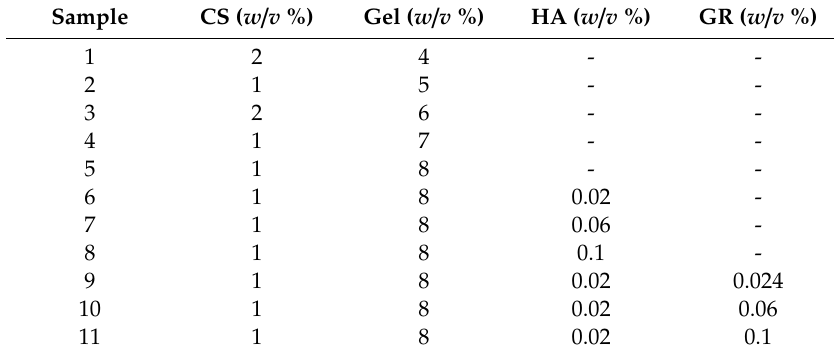
Table 1. Composition ratio of di ff erent bio-ink.